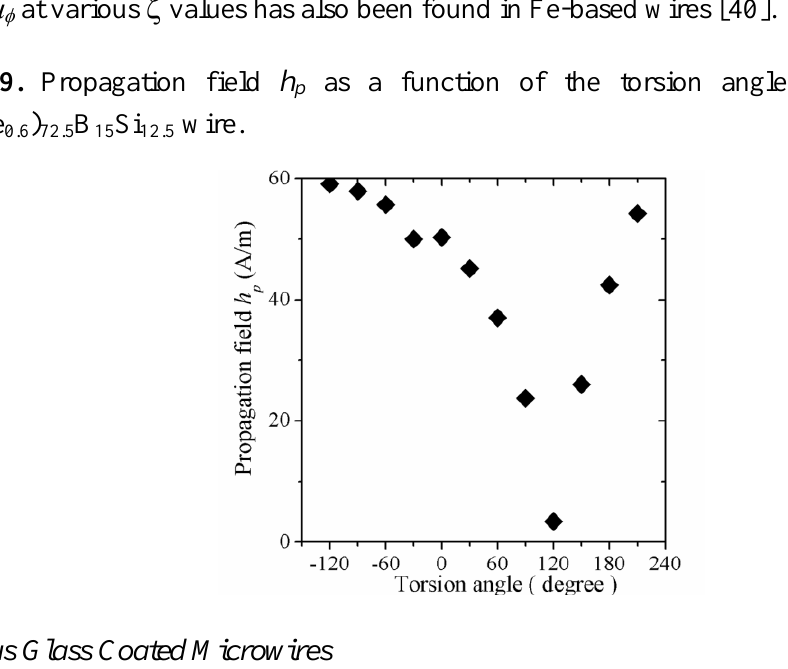
as a function of the torsion angle for amorphous p